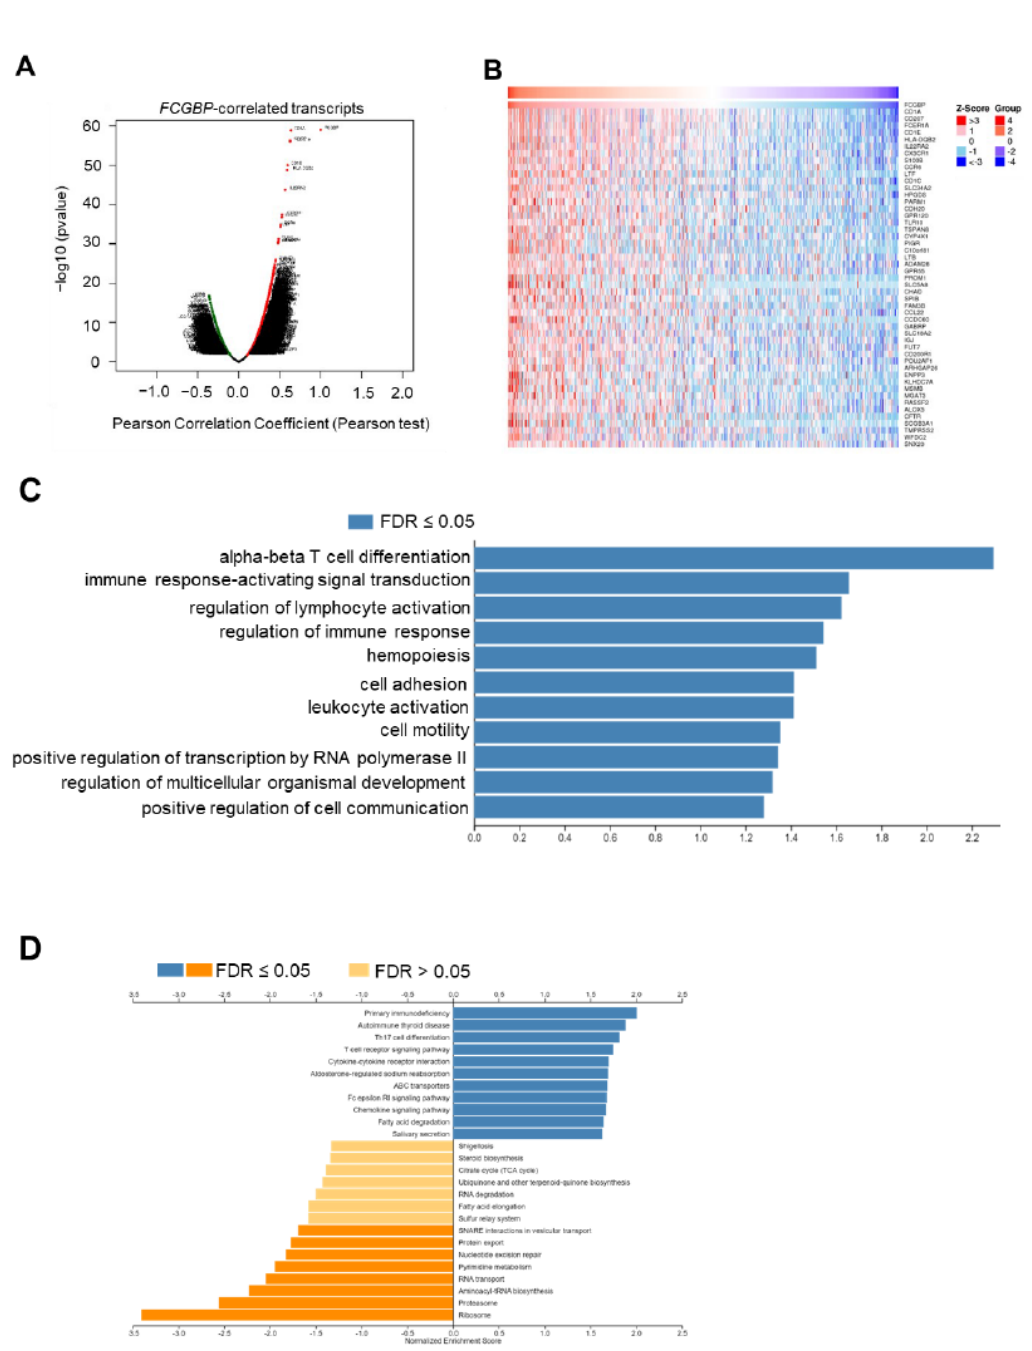
Figure 5. The FCGBP -correlated transcripts and enrichment analysis. ( A ) LinkedOmics showed the volcano map of 20,163 FCGBP co-expressed transcripts in 517 HNSCs by the Pearson correlation analysis (red: positive; green: negative). ( B ) The heat maps displayed the top 50 transcripts positively correlated to the FCGBP level. ( C ) The bar diagram demonstrated the co-expressed transcripts with significantly enriched GO (Biological Process) annotations ( p < 0.05 and FDR < 0.05). ( D ) Gene Set Enrichment Analysis (GSEA) showed the enriched KEGG pathways (FDR < 0.05).